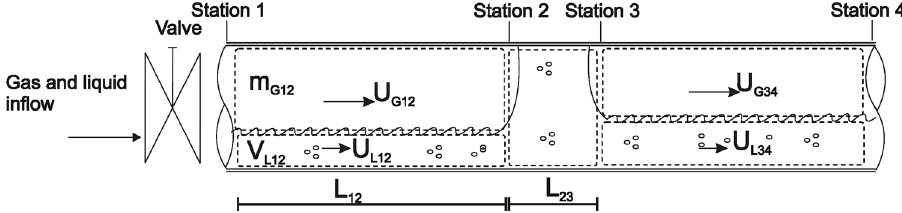
Figure 7. System configuration: inlet choke and pipeline with a slug and two areas of stratified flow, control volumes and independent variables